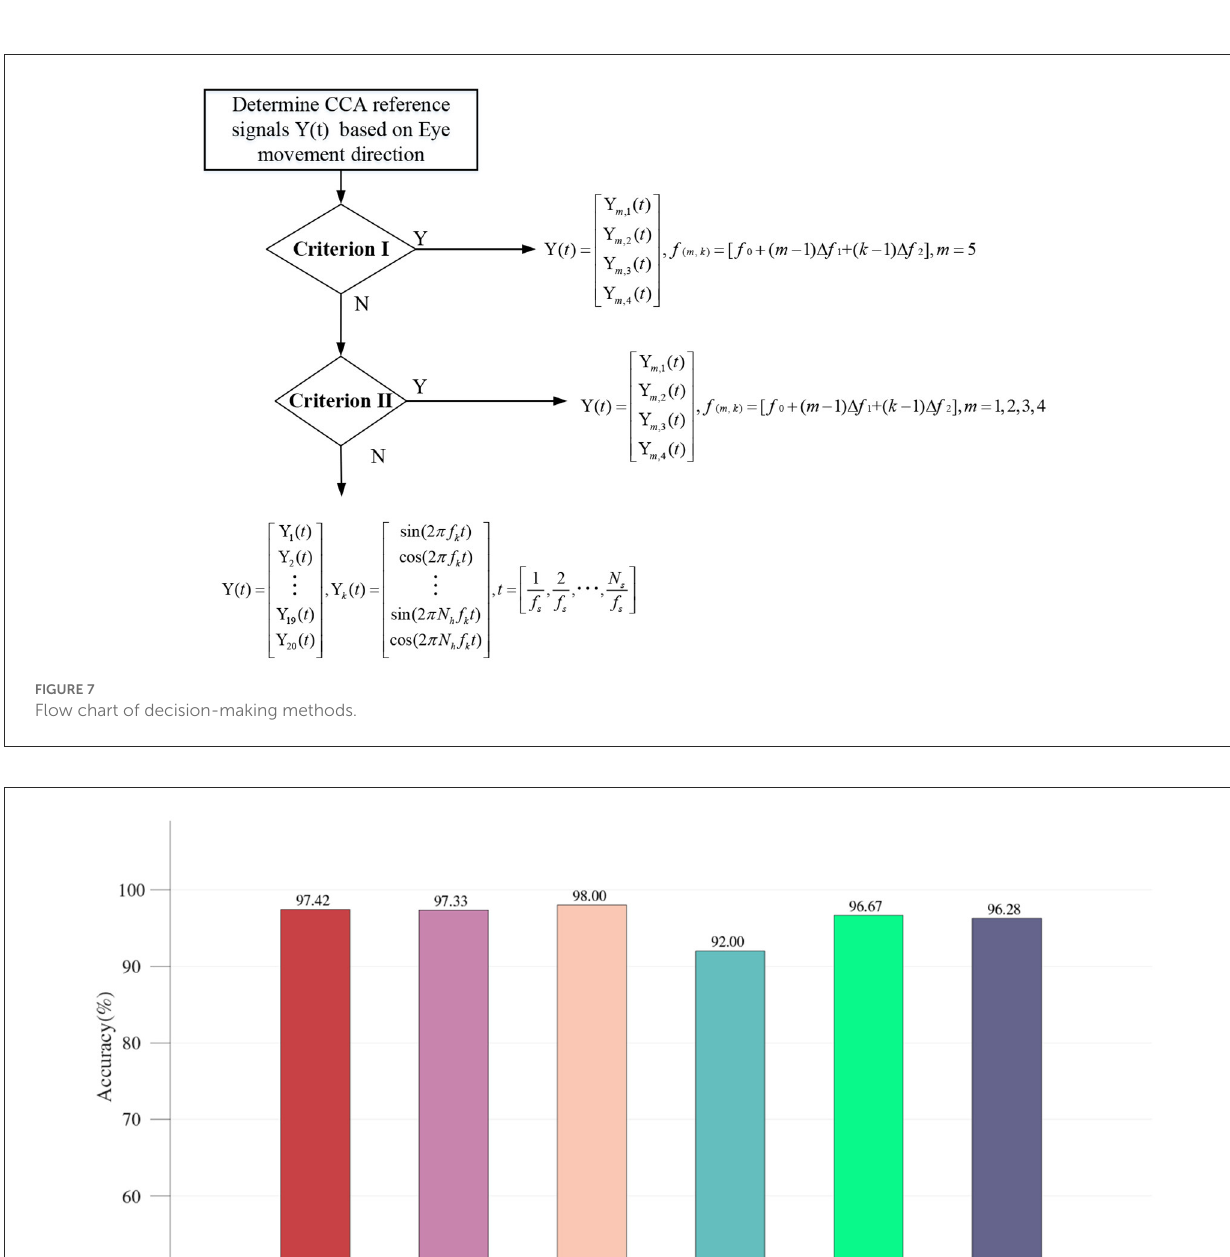
Where M is the number of characters. P is the accuracy, and T is the average response time. Each experiment included 1.6 s stimulation and 0.5 s rest time, so T was fixed at 2.1